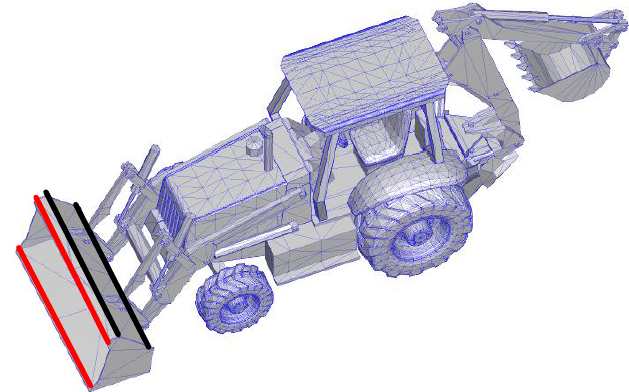
Figure 15. The model of the backhoe. Remote Sens. 2018 , 10 , x FOR PEER REVIEW 18 of 19